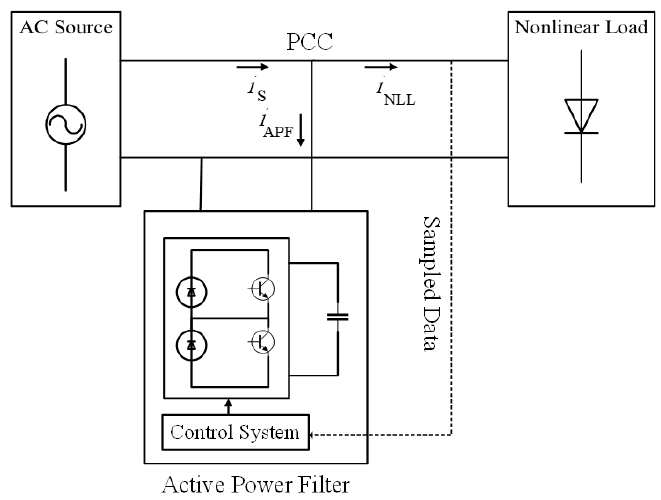
Figure 1. Diagram of an APF used to protect the source from harmonic content of the nonlinear load.